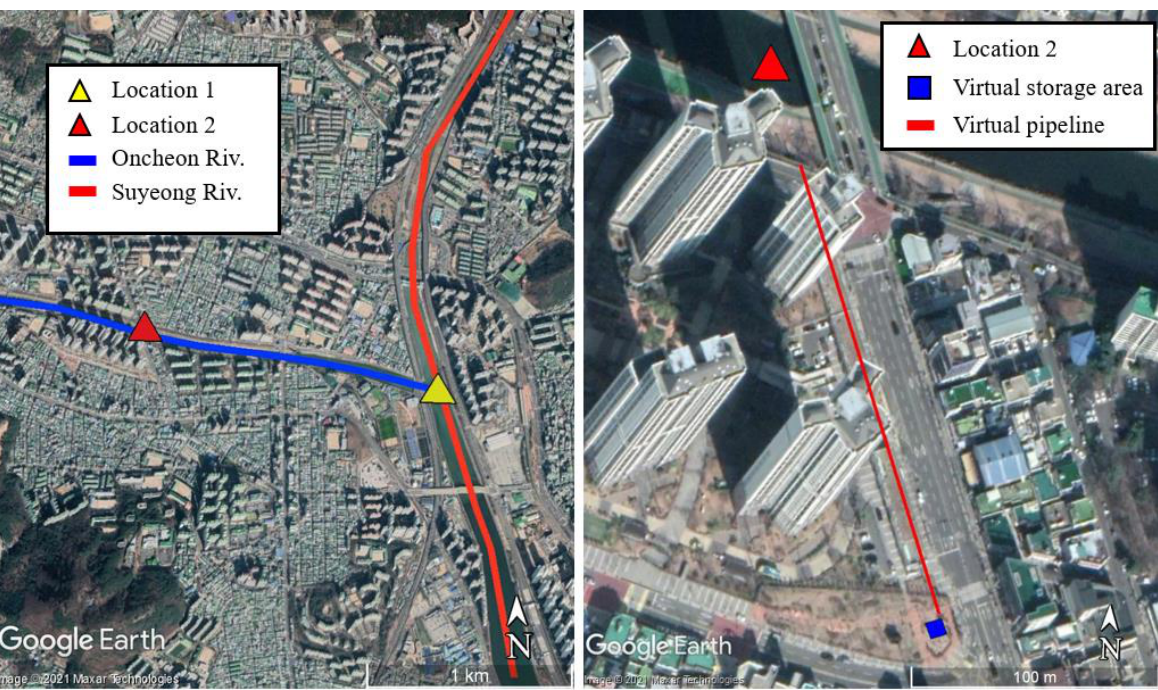
Figure 13. Location of virtual storage area.